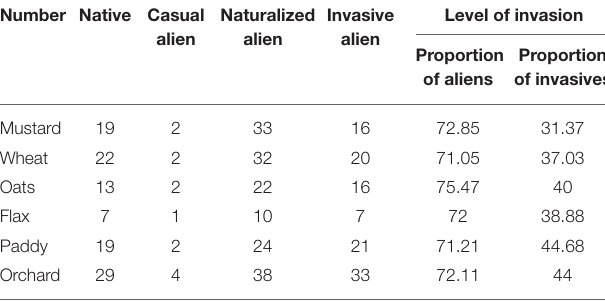
TABLE 6 | Level of invasion expressed as the proportion of aliens and proportion of invasives in different